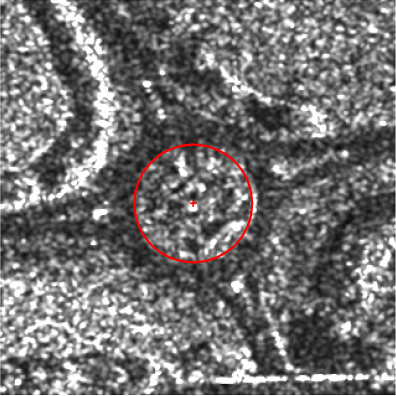
Figure 7. The SAR image and the resulting circle after the match- ing